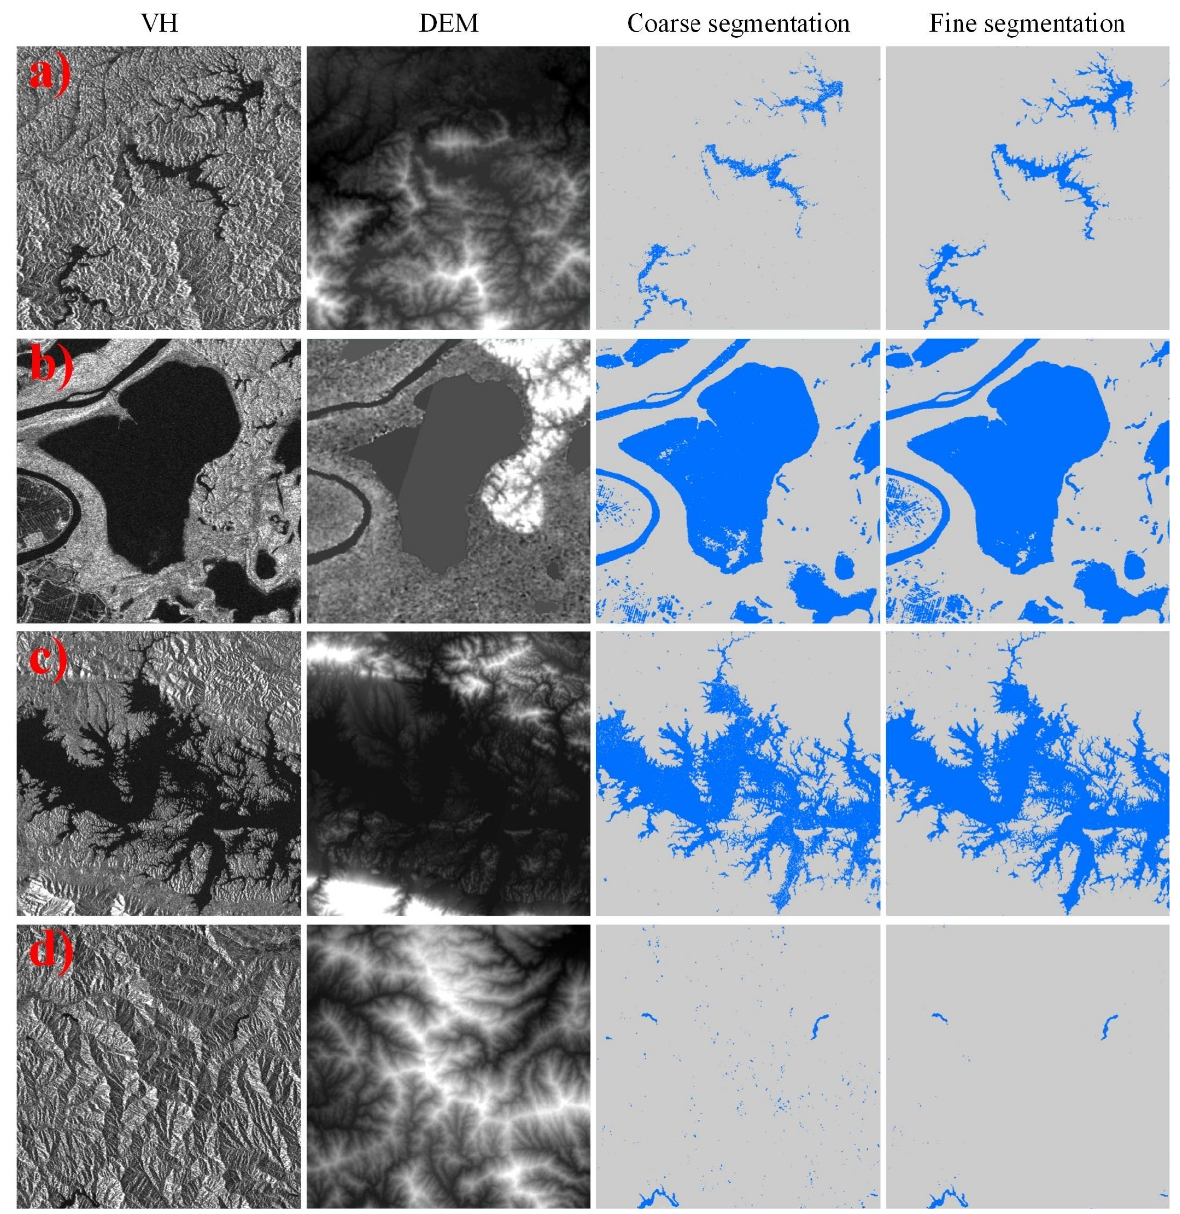
Figure 4. Examples of the re fi ned segmentations for several regions. ( a ) The water bodies in mountainous areas. ( b ) The rivers and the lakes. ( c ) The lakes. ( d ) The mountain areas.